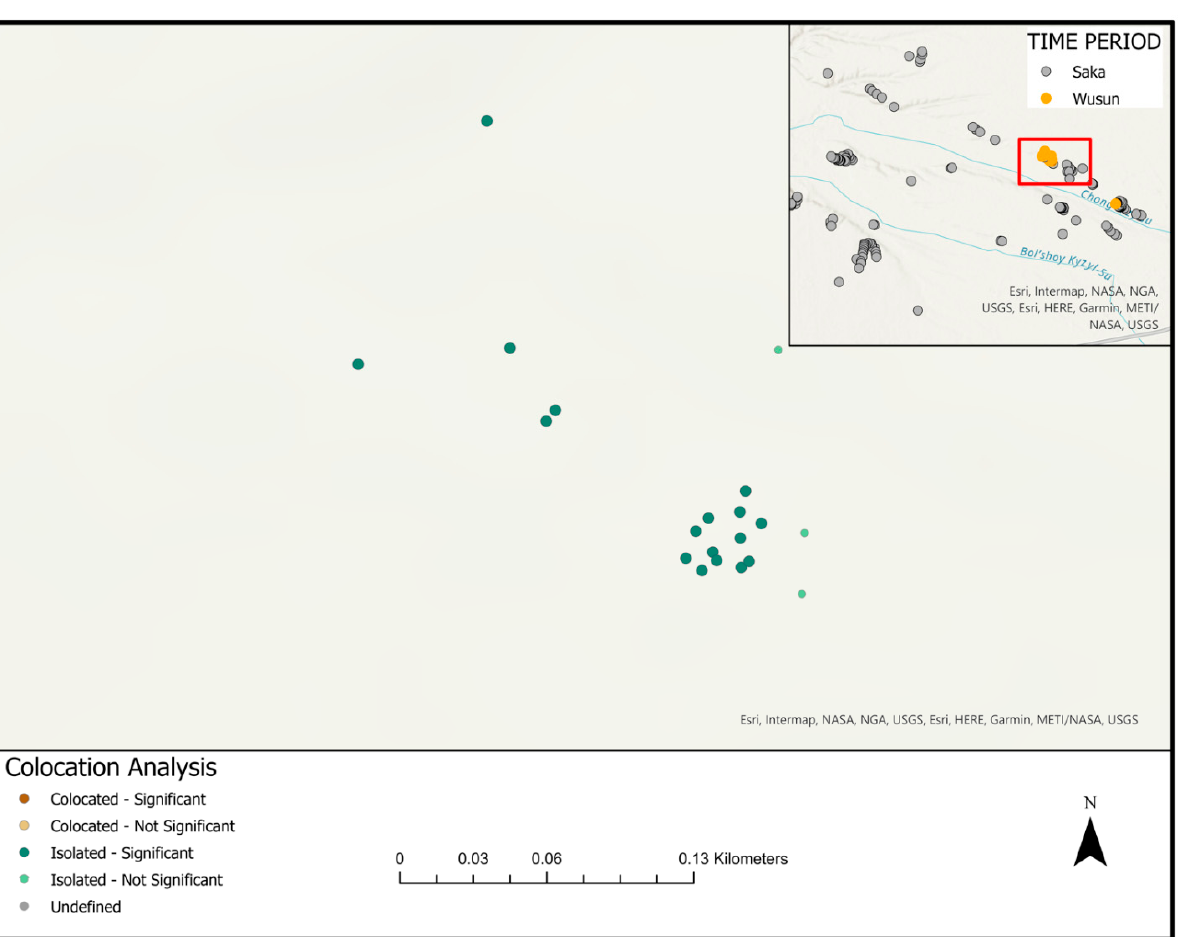
Wusun sites, are in part, driving the statistical isolation (Table 6), whereas the Saka locations exhibit a dispersed spatial arrangement (Figure 11).